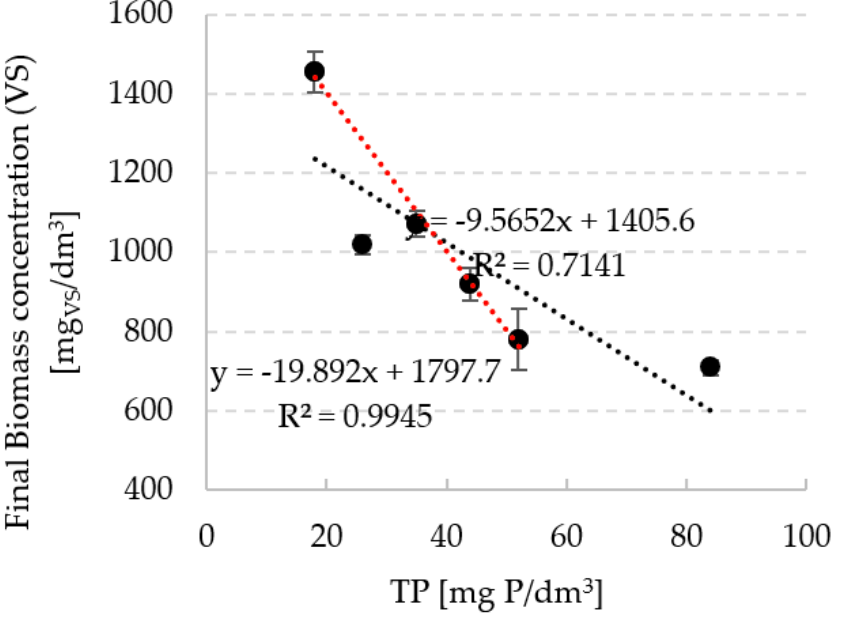
Figure 5. Correlation between initial total phosphorus (TP) concentration and final production of microalgae biomass.